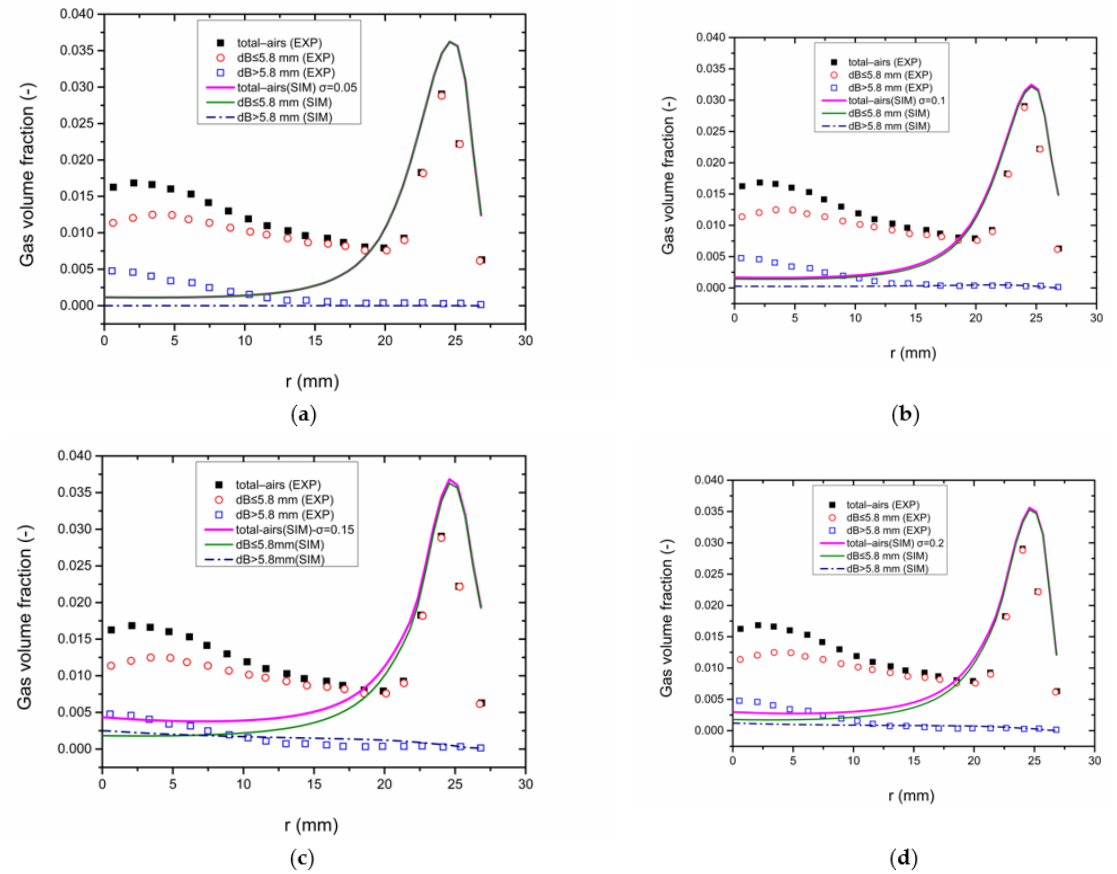
Figure 18. Calculation results of the multi–fluid model with unimodal distribution function with different standard deviations. ( a ) σ = 0.05; ( b ) σ = 0.1; ( c ) σ = 0.15; ( d ) σ =